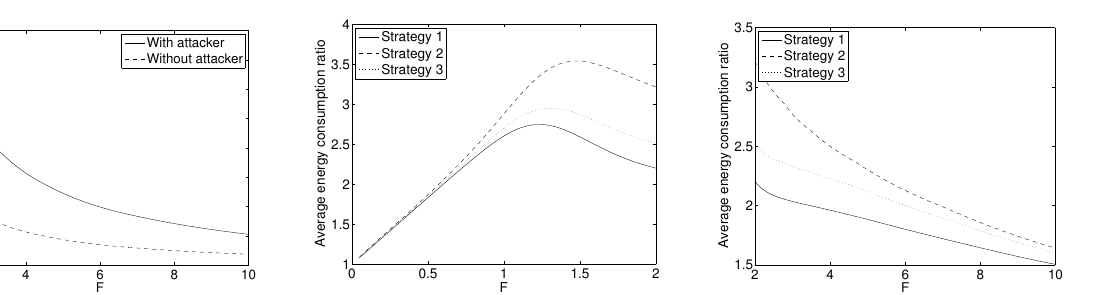
Figure 8: Comparison of R with or without attacker. Strategy 1